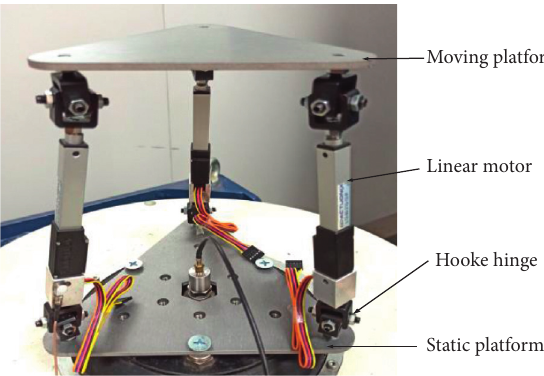
Figure 19: The prototype of the vibration